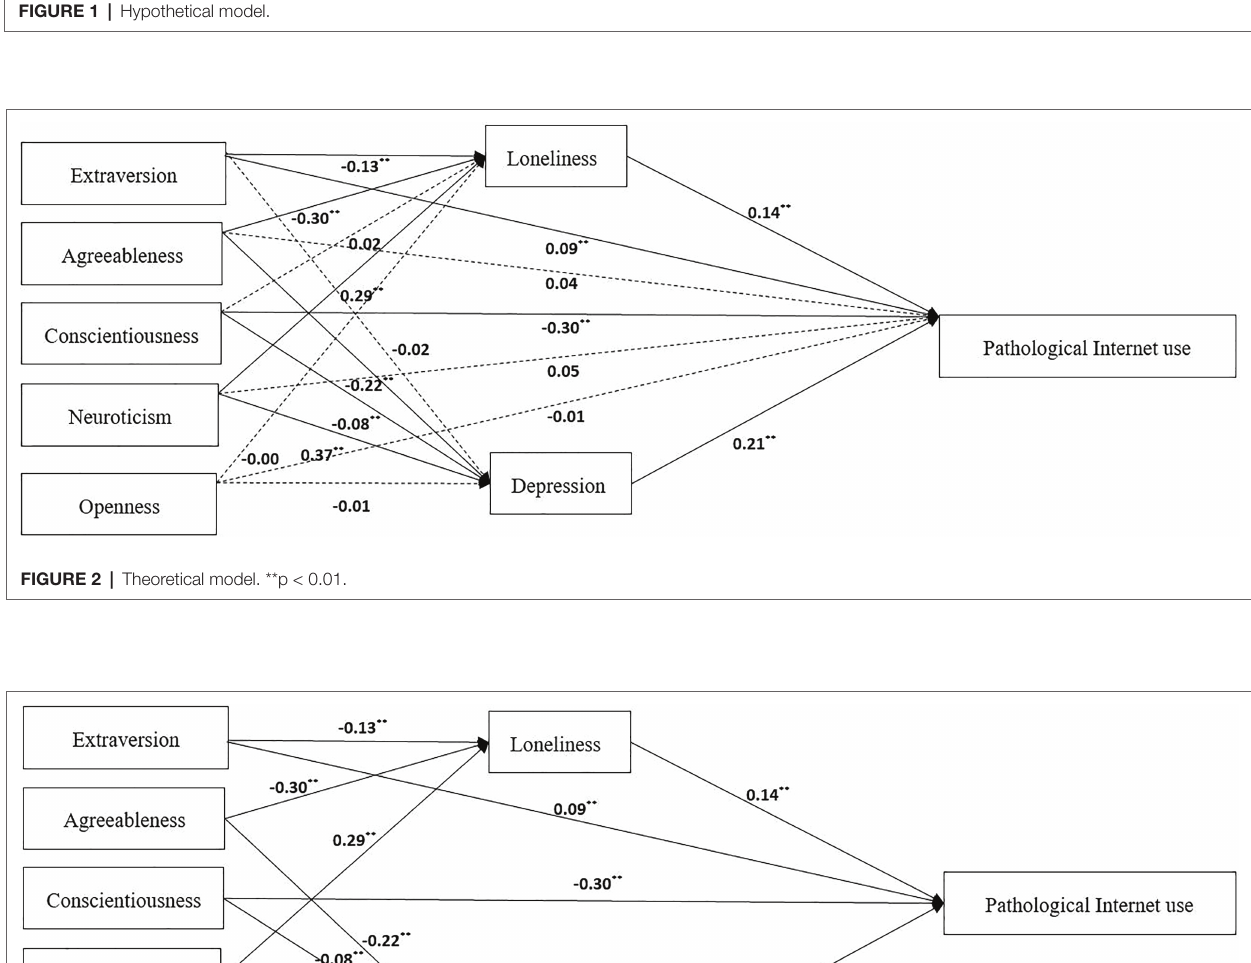
FIGURE 1 | Hypothetical